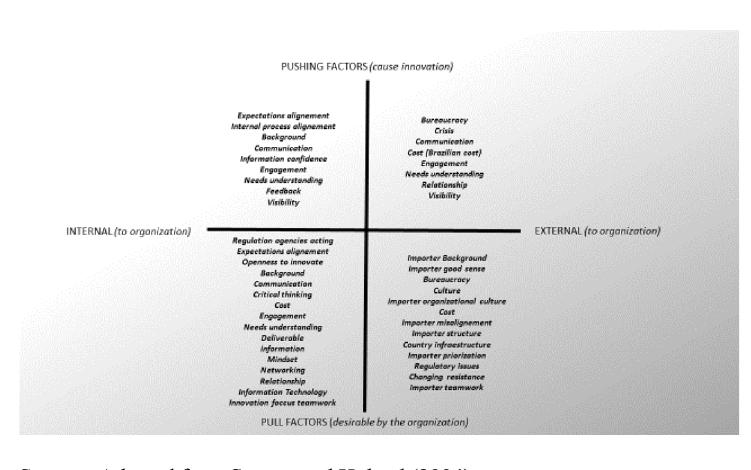
Figure 1. Reproduction of TPLs innovation drivers